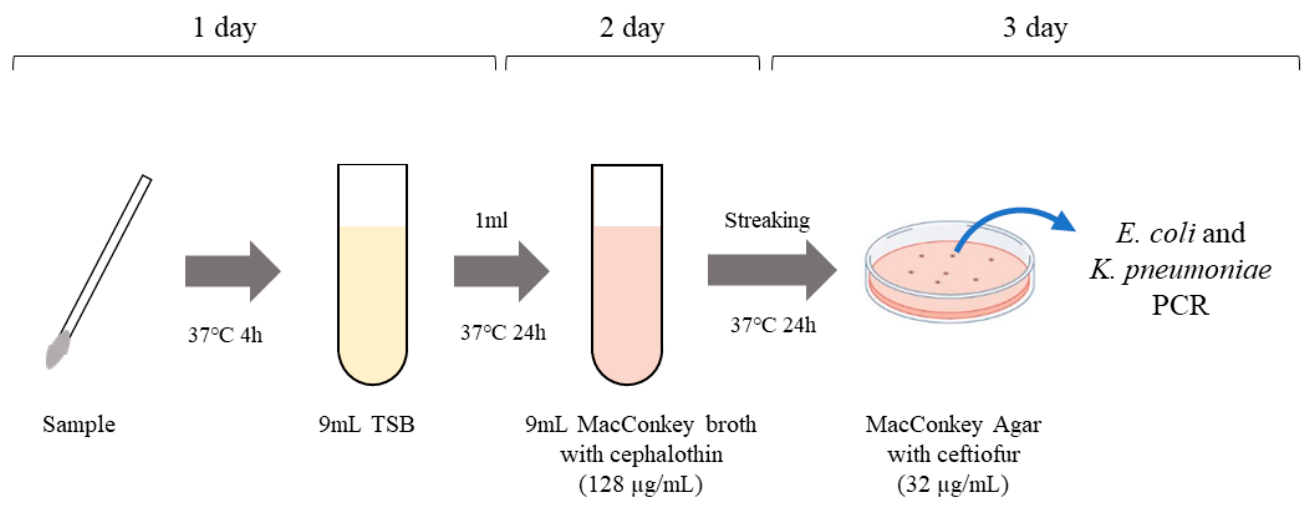
Figure 1. Schematic workflow for isolation of ESBL and pAmpC β -lactamase-producing E. coli and K. pneumoniae . TSB, tryptic soy broth.